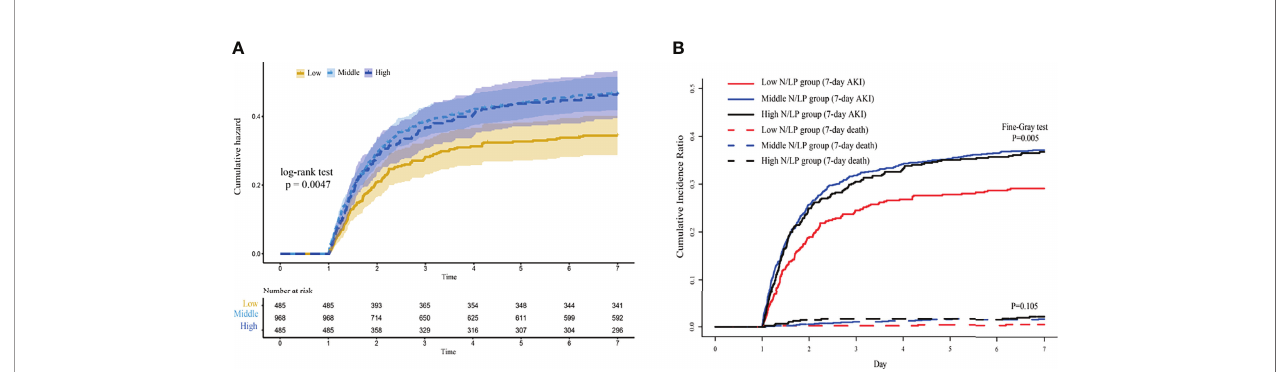
multivariate Cox proportional hazard model or competing-